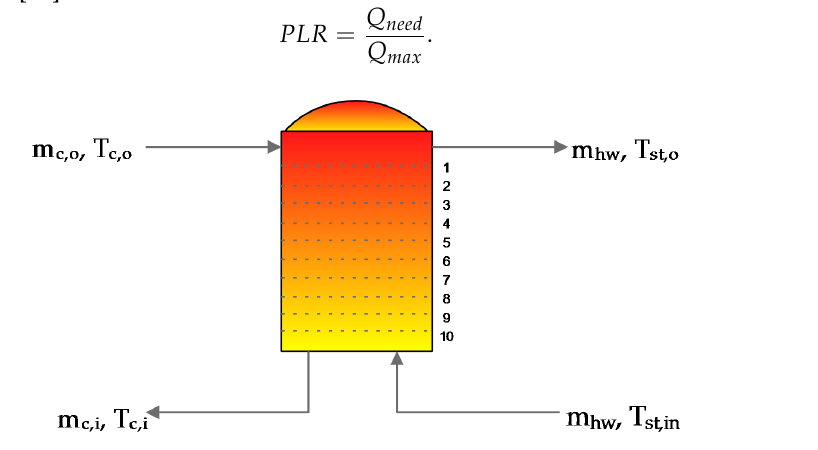
Figure 5. Hot water storage